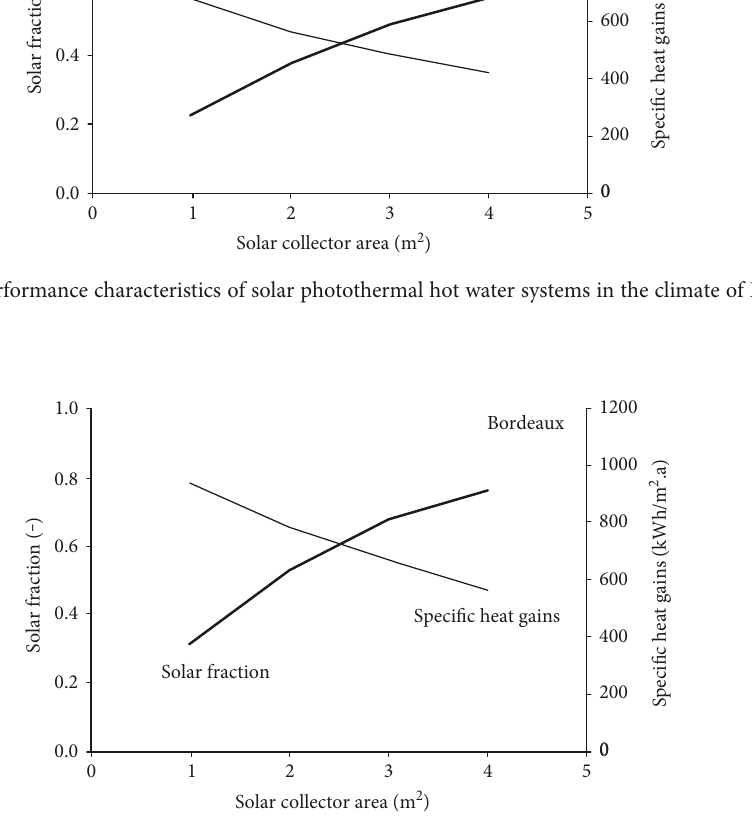
Figure 10: Performance characteristics of solar photothermal hot water systems in the climate of Bordeaux.